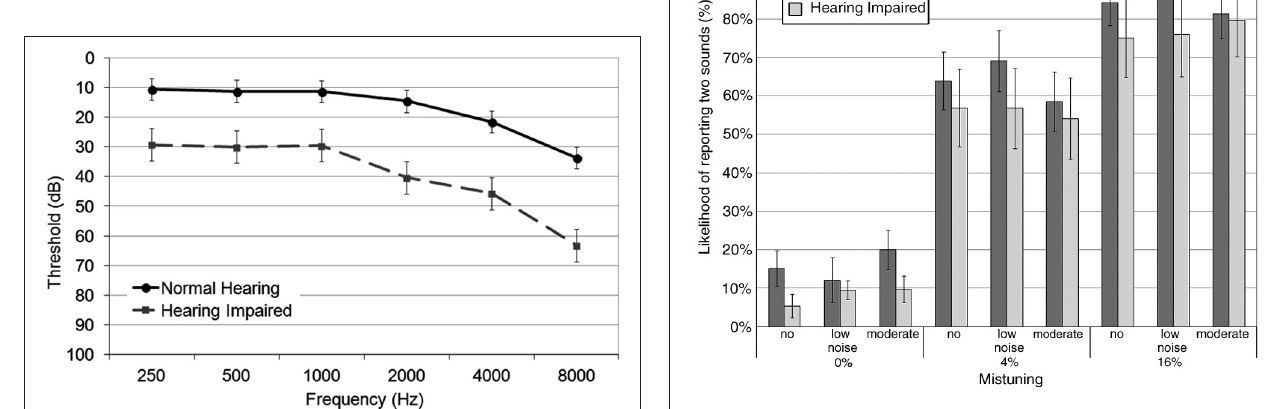
FIGURE 1 | Group mean audiometric thresholds in normal hearing and hearing impaired older adults for octave frequencies between 250 and 8000 Hz. The error bars indicate standard error of the mean.